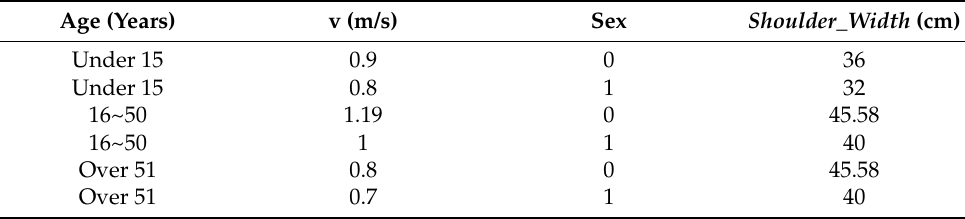
Table 3. Partial data recorded by